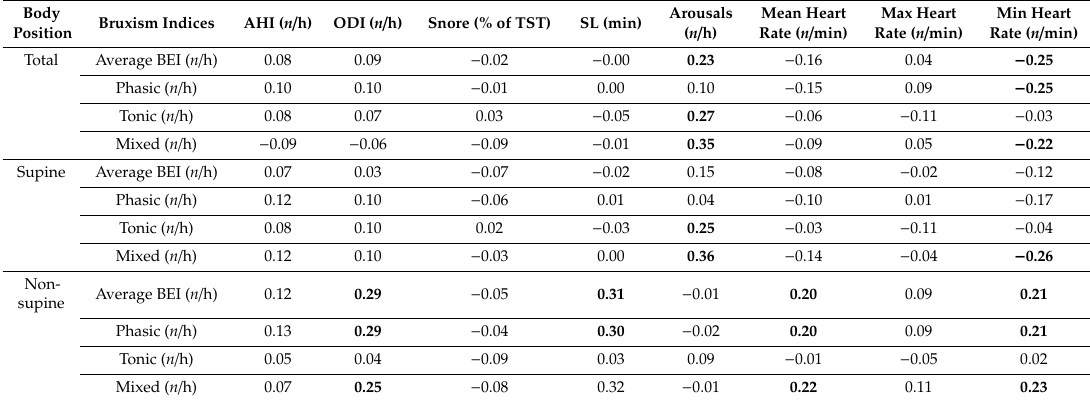
Table 3. Polysomnographic indices correlated with bruxism and the body position. Body Position Bruxism